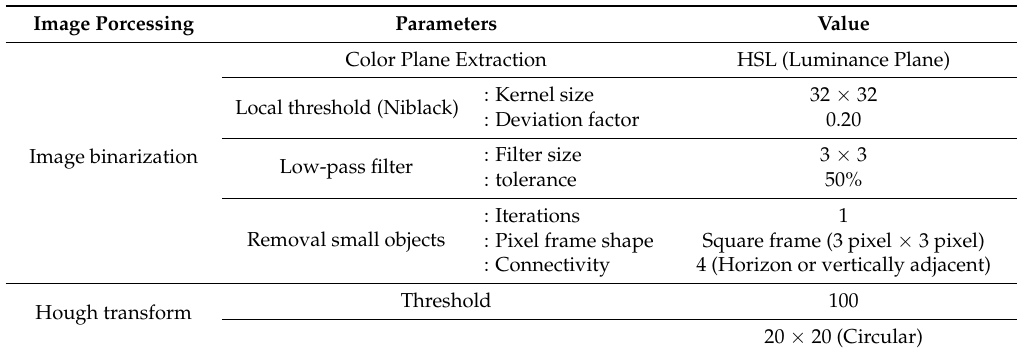
Table 1. Parameter of image processing.